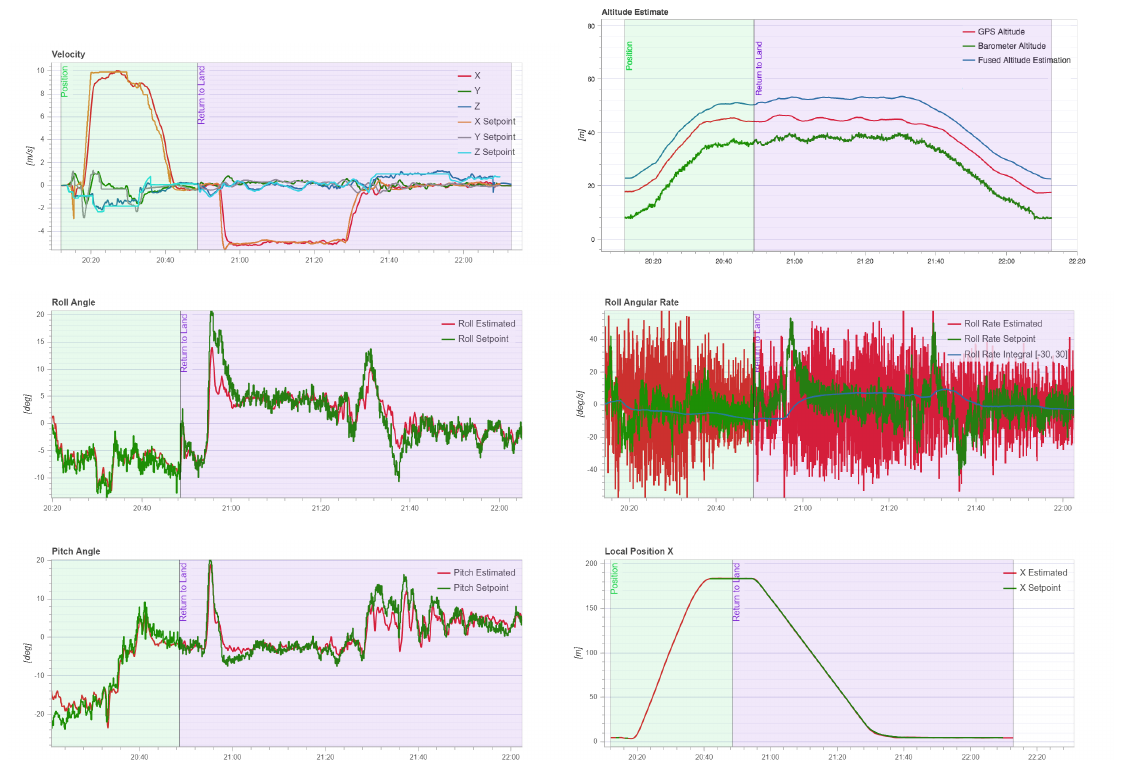
Figure 11. Plots of the velocity, attitude, and altitude over time during the landing